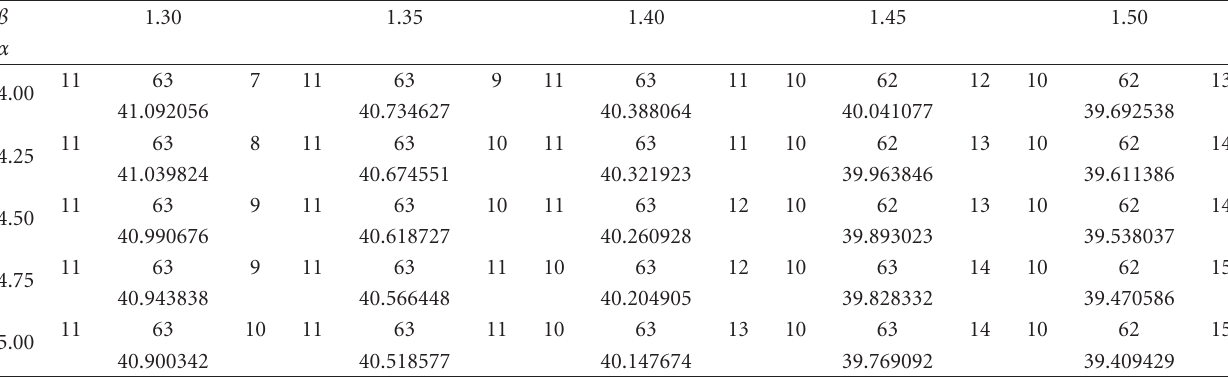
Table 9: Influence of the postponed demand rate and vacation time rate on the optimal values ( λ = 14, γ = 1 . 4, μ = 4, p = 0 . 85).